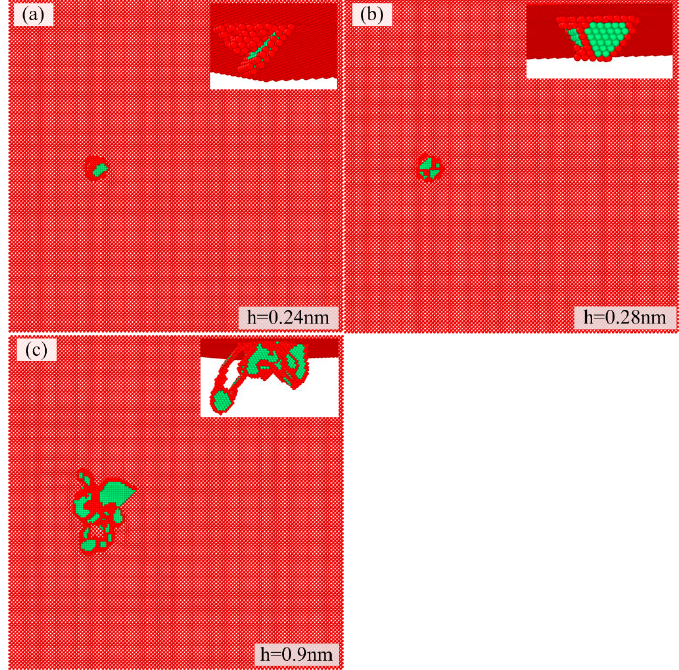
Figure 9. Atom configuration during indentation process with residual tensile stress λ = 0.17 at various indentation depths: ( a ) 0.24 nm; ( b ) 0.28 nm; ( c ) 0.9 nm. The green color shows stacking faults.